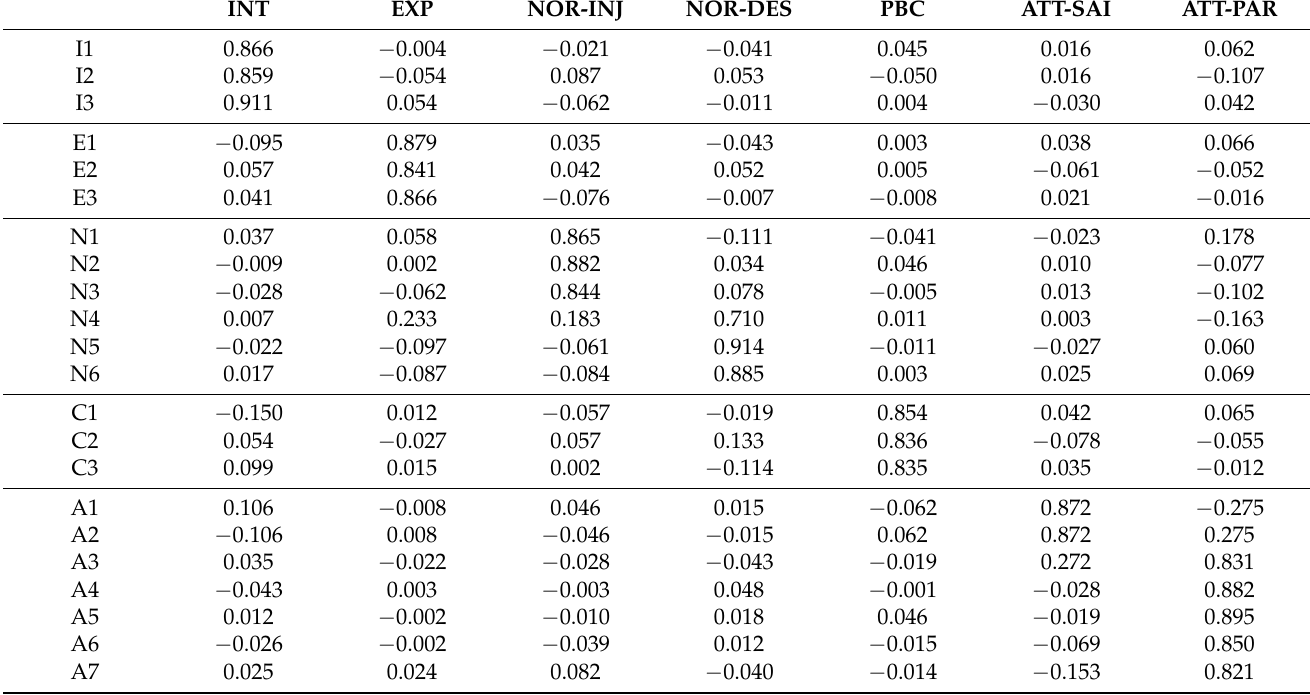
Table A2. Loadings of the observed variables on the latent